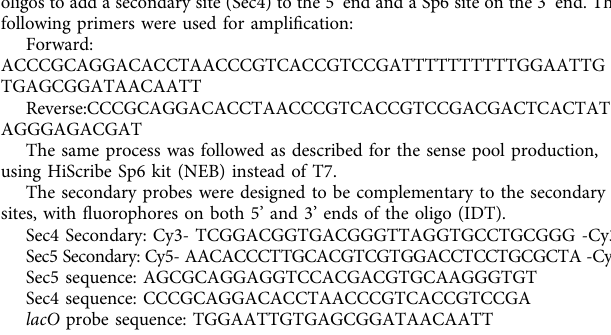
Fig. 5c, or three times for other fi gures to con fi rm results. Number of scored cells, which are randomly chosen from at least 10 testes for each experiments, is shown in each